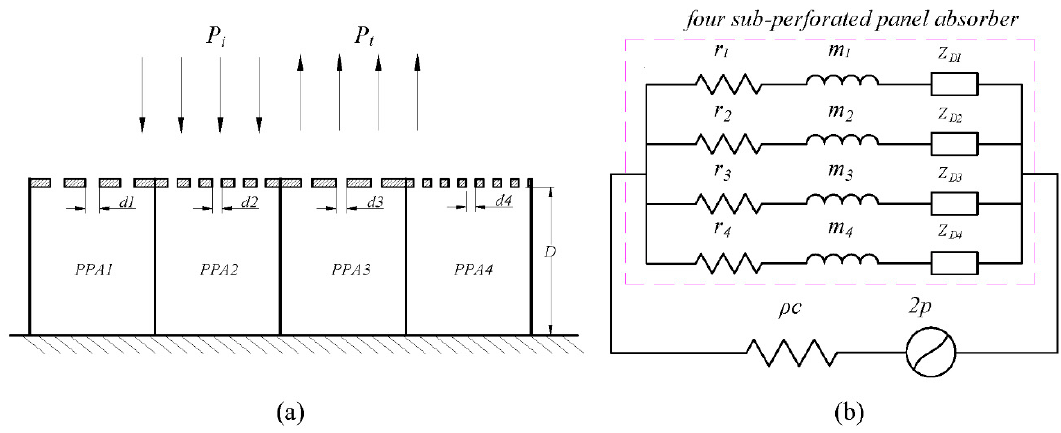
Figure 1. Schematic diagram and electrical equivalent circuit model: ( a ) Schematic of the four parallel-arranged perforated panel absorbers. ( b ) The electrical equivalent circuit model of the four parallel-arranged perforated panel absorbers.